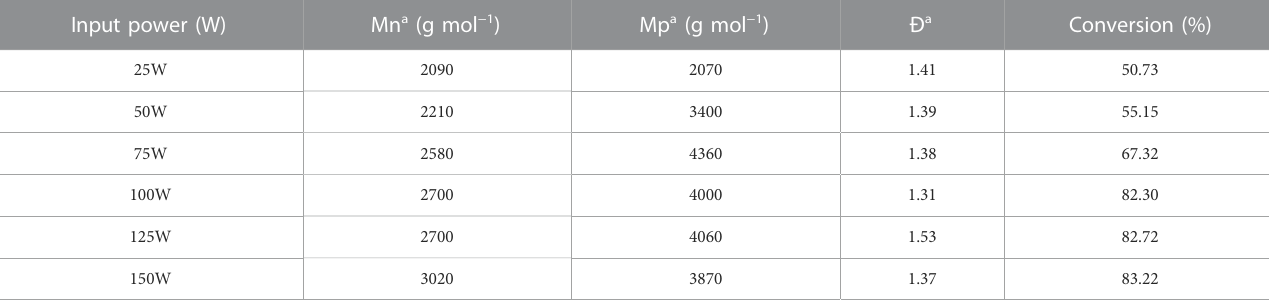
TABLE 4 Average results of ROP of CL with FeCl 3 and BzOH using various input power at [M]:[C] ratio of 400:1 for 3 min with HH. Input power (W)